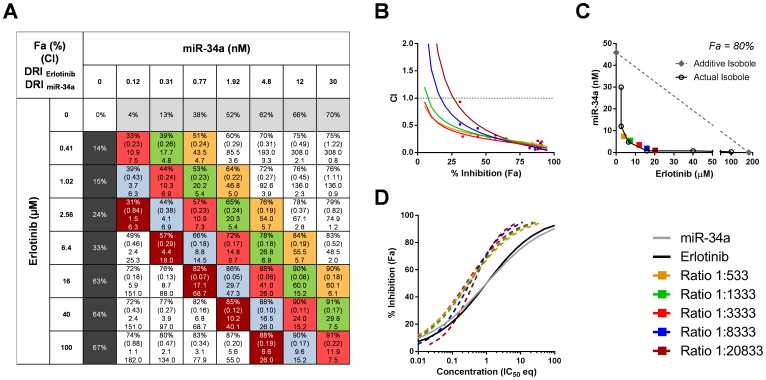
Multiple ratios of erlotinib and miR-34a cooperate synergistically in A549 cells.(A) Summary table showing potency (Fa), CI and DRI values of erlotinib and miR-34a combined at various concentrations and ratios. The molar miR-34-erlotinib ratios 1∶533, 1∶1333, 1∶3333 (IC50:IC50 ratio), 1∶8333, and 1∶20833 are indicated in yellow, green, red (IC50:IC50 ratio), blue and maroon. (B) Combination index plot of various drug ratios. CI values from actual data points are indicated by symbols. (C) Isobologram at 80% cancer cell inhibition. Colored symbols represent the 80% isobole of various ratios. The black line represents the isobole derived from actual erlotinib-miR-34a combinations that produced 80% (±2%) inhibition. (D) Curve shift analysis of various drug ratios.